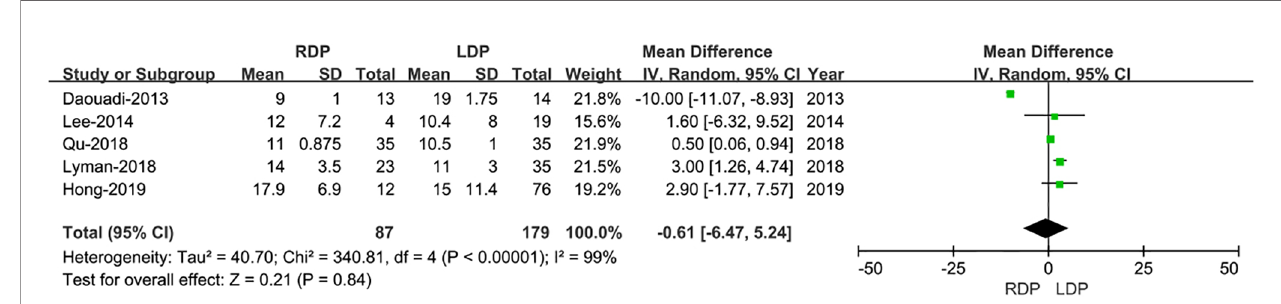
FIGURE 5 | Forest plot of comparison of RDP versus LDP for lymph node dissection.